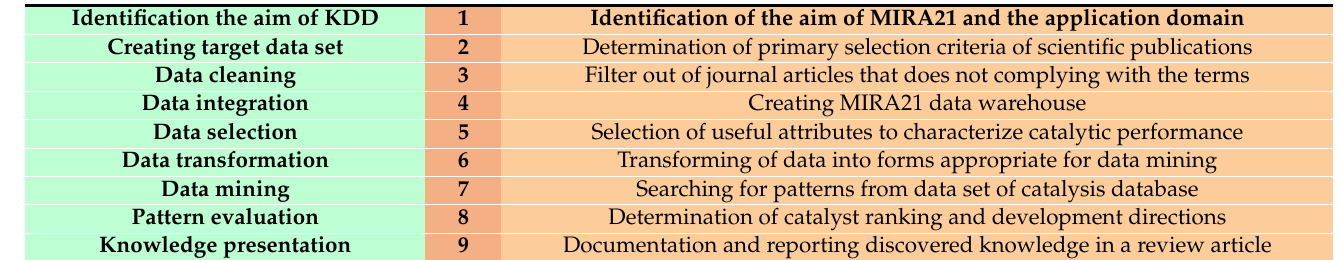
Table 1. Steps for establishment of MIRA21 model as a process of Knowledge Discovery from Data.